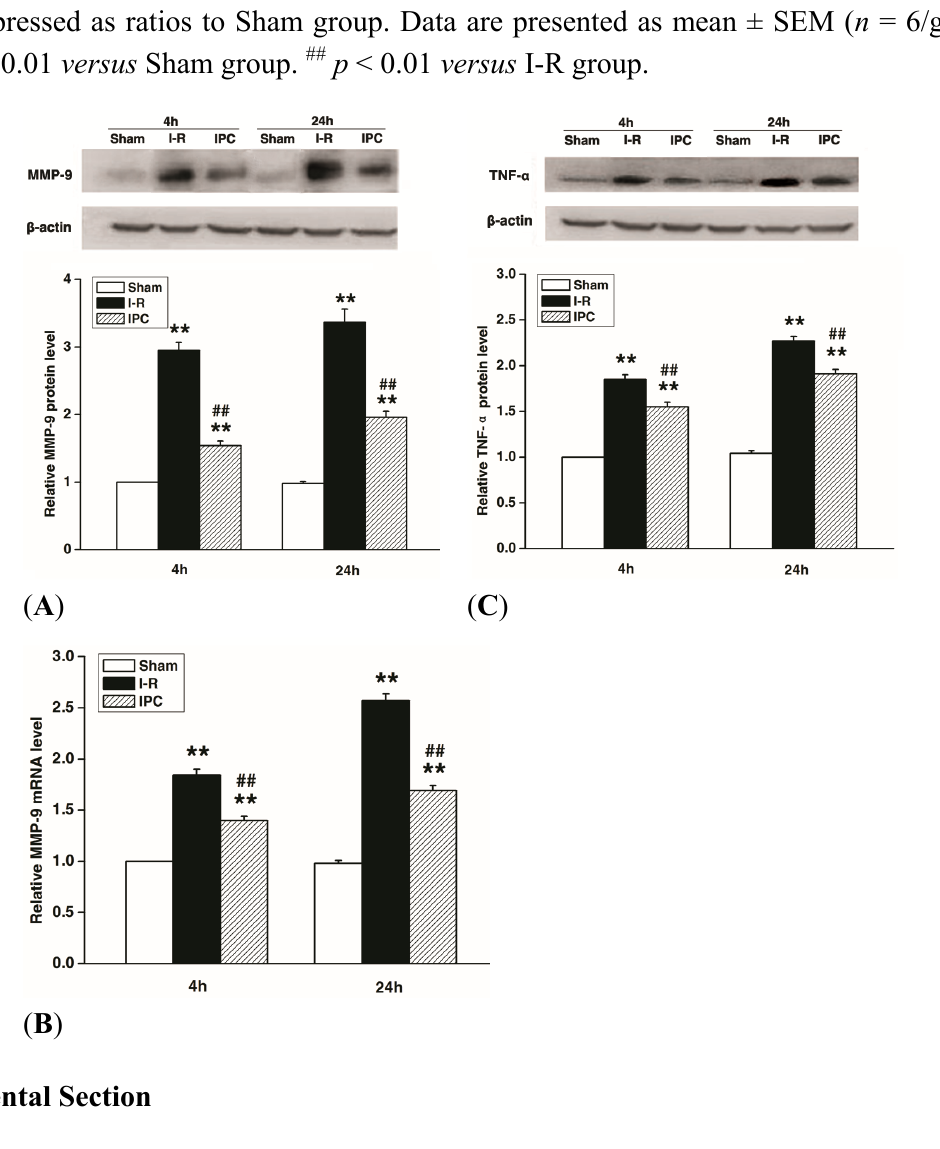
Figure 4. IPC inhibits MMP-9 and TNF- α expression after spinal cord ischemia-reperfusion (I-R) injury. ( A ) Representative Western blot and quantitative protein analysis of MMP-9 in the spinal cord at 4 and 24 h after injury; ( B ) Real-time PCR analysis of MMP-9 mRNA expression in the spinal cord at 4 and 24 h after injury; ( C ) Representative Western blot and quantitative protein analysis of TNF- α in spinal cord at 4 and 24 h after injury. Levels are expressed as ratios to Sham group. Data are presented as mean ± SEM ( n =